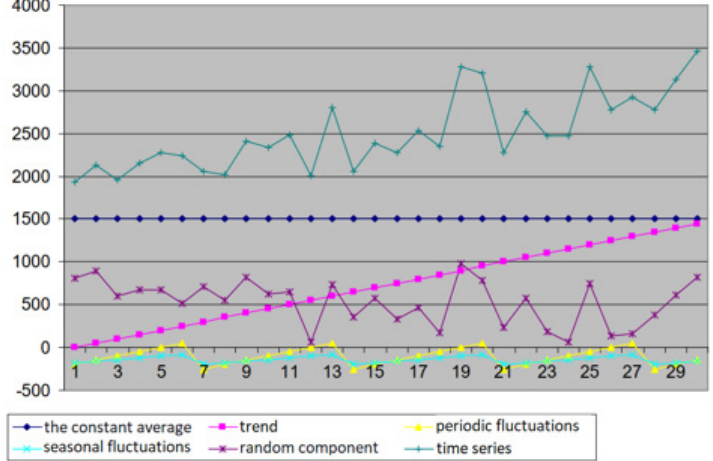
Fig. 1. A time series and its components on the example of fuel sales level (source: Kiersztyn,